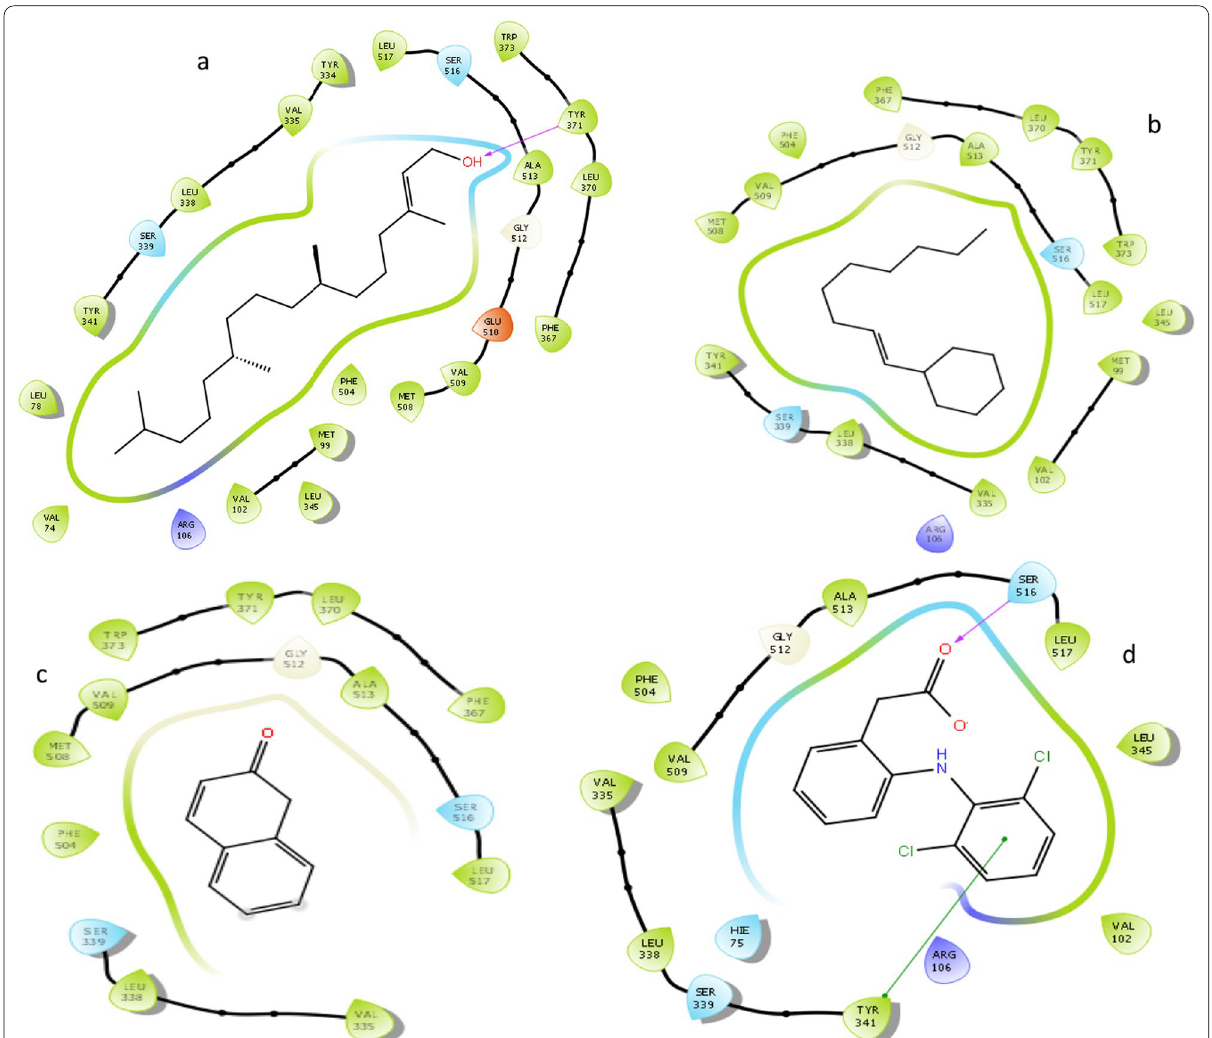
Fig. 4 2D molecular contacts profiling for the last poses of Cox-2-hit compounds, viz. a Phytol, b 1-cyclohexylone, c 2-(1H)-Naphthalenone, d